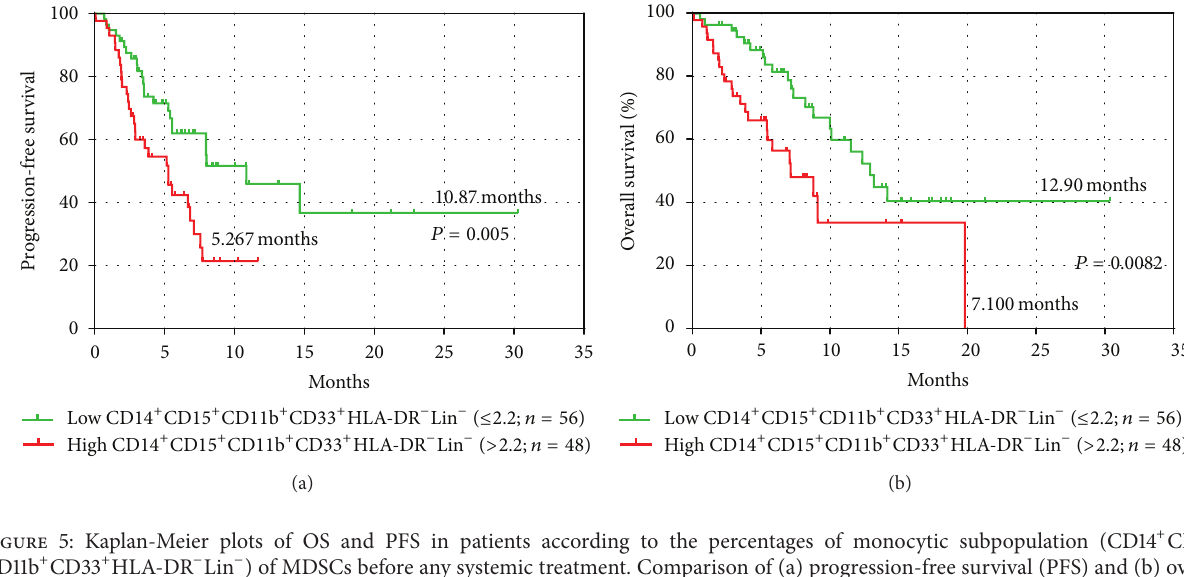
CD11b + CD33 + HLA-DR − Lin − ) of MDSCs before any systemic treatment. Comparison of (a) progression-free survival (PFS) and (b) overall survival (OS) between normal ( ≤ 2.2%) and increased ( > 2.2%) percentages of CD14 + CD15 + CD11b + CD33 + HLA-DR − Lin − MDSC.